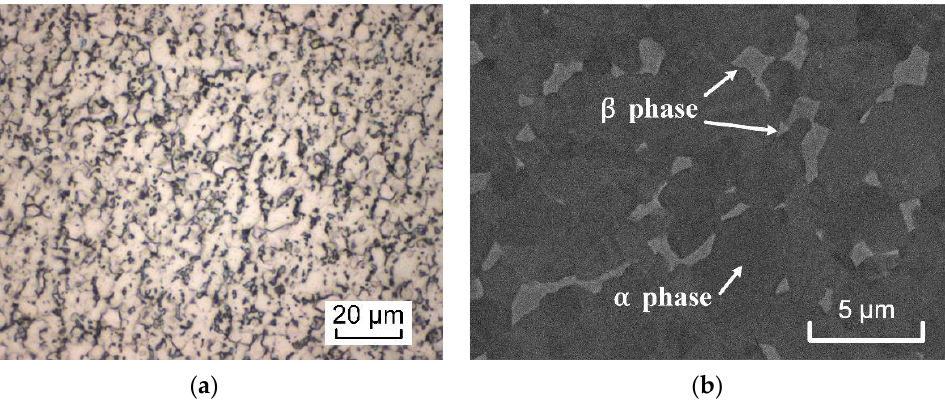
Figure 1. ( a ) Optical microscope image for the as-received Ti6Al4V; ( b ) SEM backscattered electron image showing α and β phases.